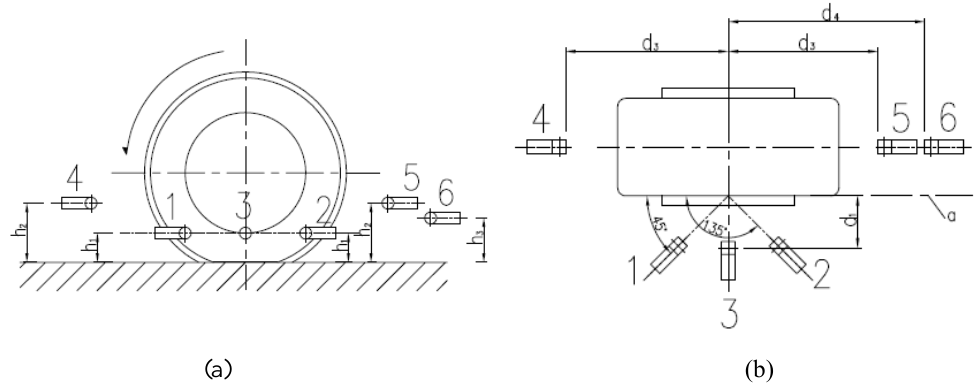
Figure 3. Microphones placements according to ISO 11819-2: ( a ) radial direction; ( b ) tangential Figure 3: Microphones placements according to ISO 11819-2: (a)radial direction; (b)Tangential direction.